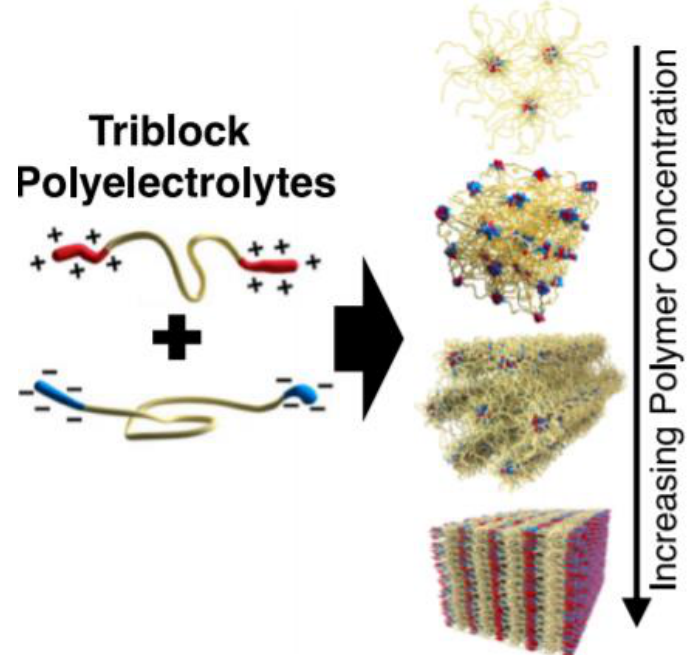
Figure 2. Illustration of spatial organization of electrostatic complexes between end-functionalized oppositely charged polyelectrolytes as a function of concentration. Reprinted with permission from [8]. Copyright 2020 American Chemical Society.